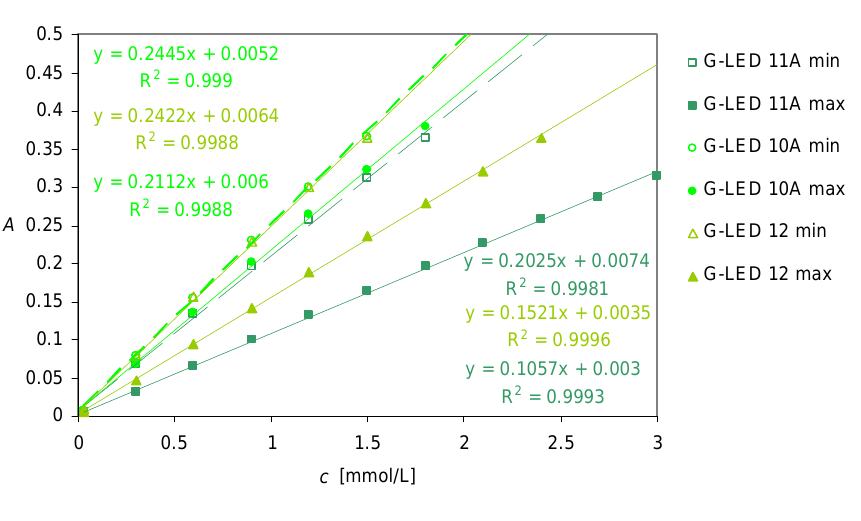
Figure 2. Linearity of the detector’s responses in the range of the green light (G-LED) for cells 10a, 11a and 12 at minimum (min) and maximum (max) light intensity.